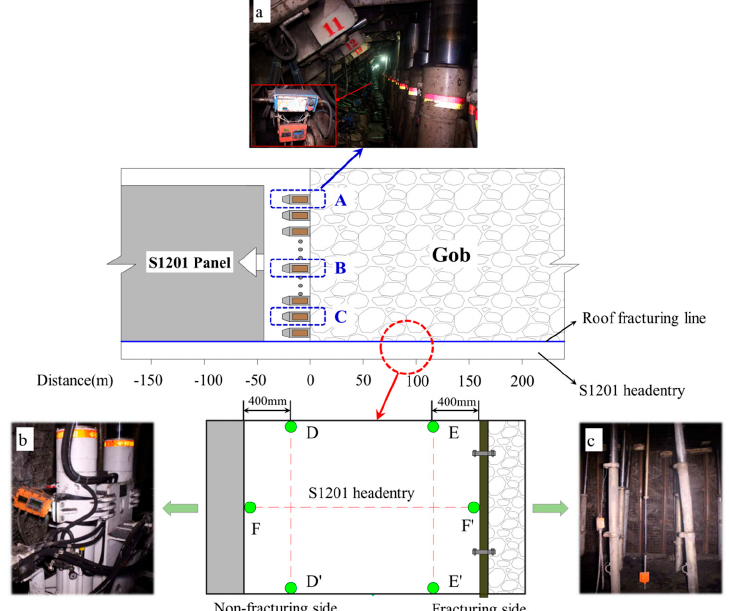
Figure 18. Sketch of the field monitoring and apparatus: ( a ) Monitoring apparatus for roof pressure of the S1201 panel; ( b ) Monitoring apparatus for roof pressure of the S1201 headentry; ( c ) Monitoring apparatus for convergence. The pressure changes in position A, B and, C measure the bearing load of hydraulic supports of the active working panel. The distance and pressure change between D pin and D ′ pin, E pin, and E ′ pin in vertical direction measure the convergence and pressure of roof to floor. The distance change between F pin and F ′ pin in horizontal direction measures the convergence of gangue rib to coal rib. The pressure change in F ′ pin measures the lateral pressure of gangues.